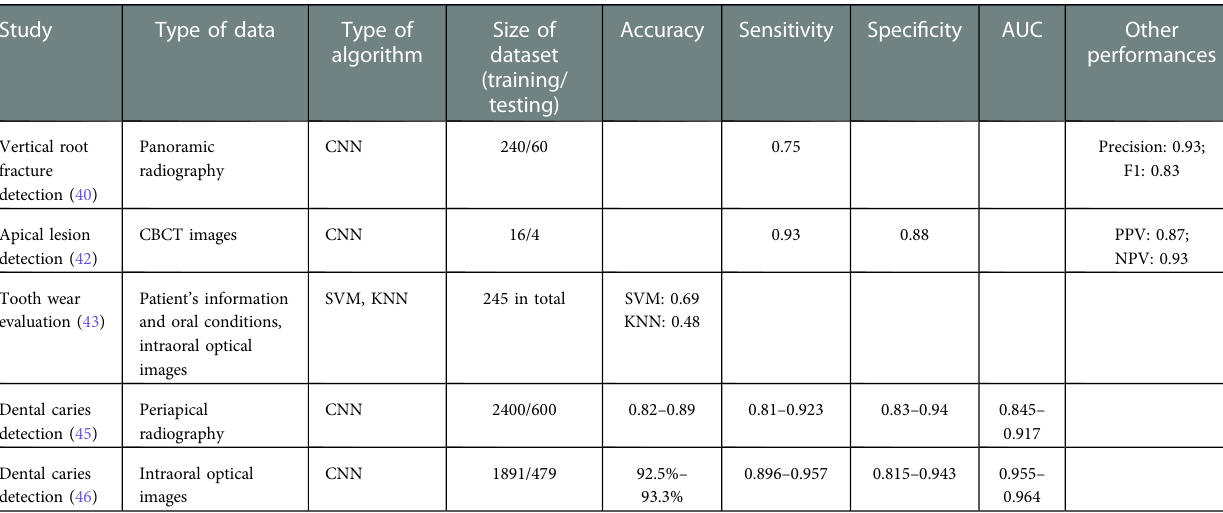
TABLE 2 Examples of AI applications in operative dentistry.